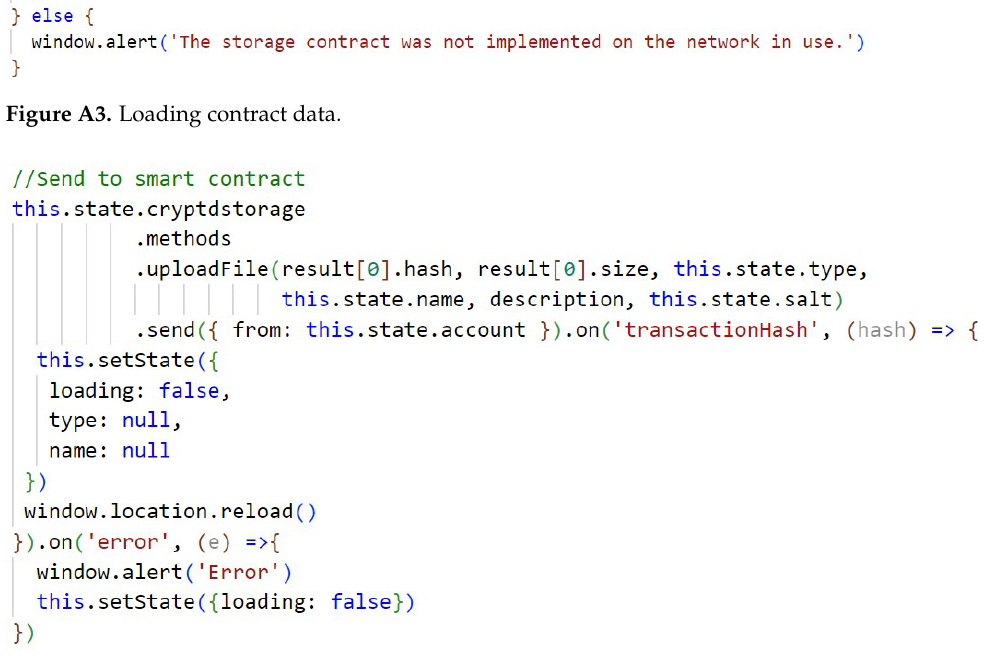
Figure A4. Sending data to the contract.